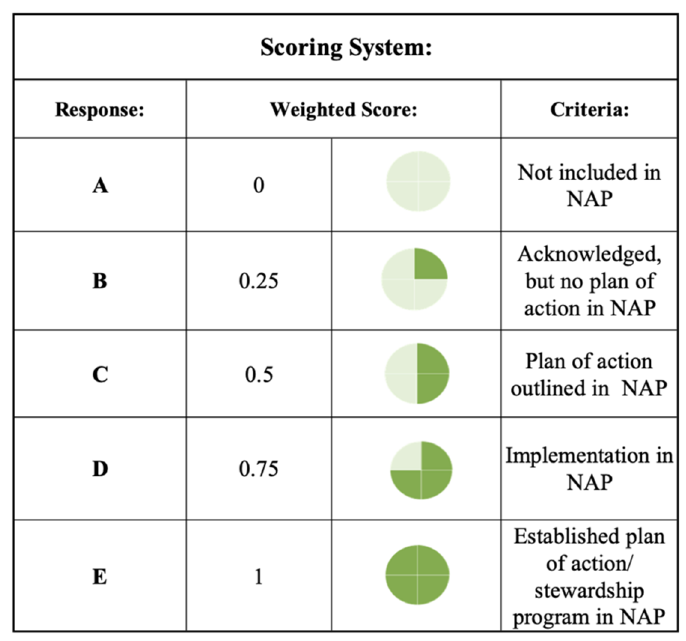
Figure 14. One Health-One Water AMR stewardship framework scoring criteria.